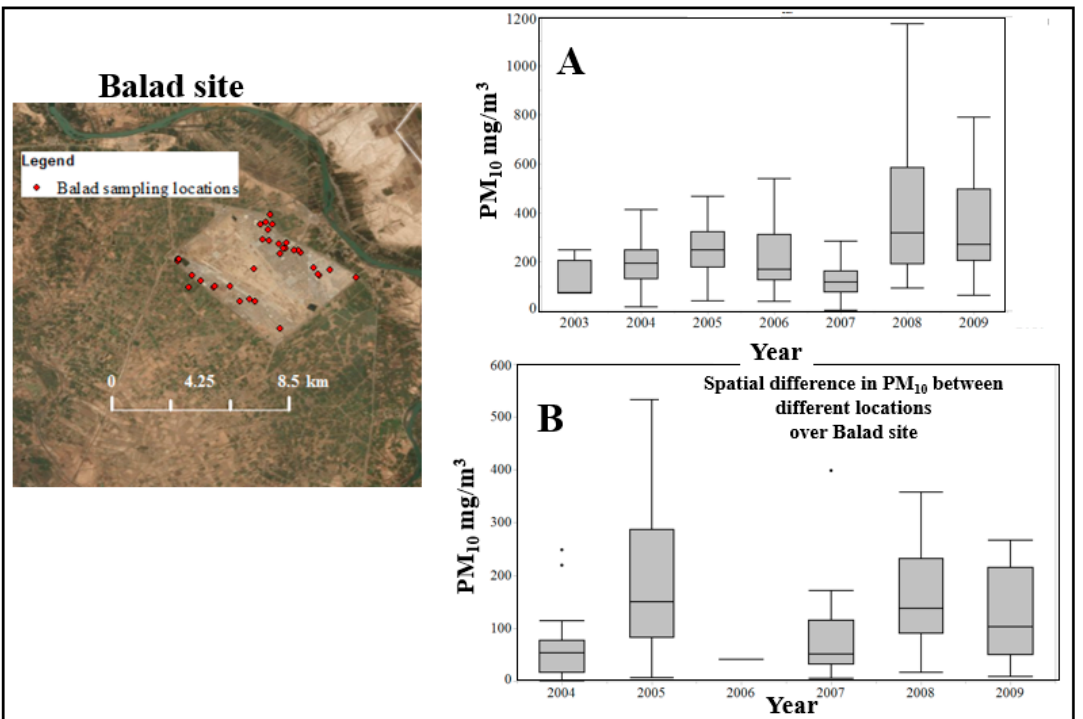
Figure 10. Balad military air base site and PM 10 sampling locations during 2004–2009 based on publically available data [60]. ( A ) Box plot of mg PM 10 per m 3 confirms the increase in PM 10 and distinct temporal pattern variability. ( B ) Spatial variability between different locations.